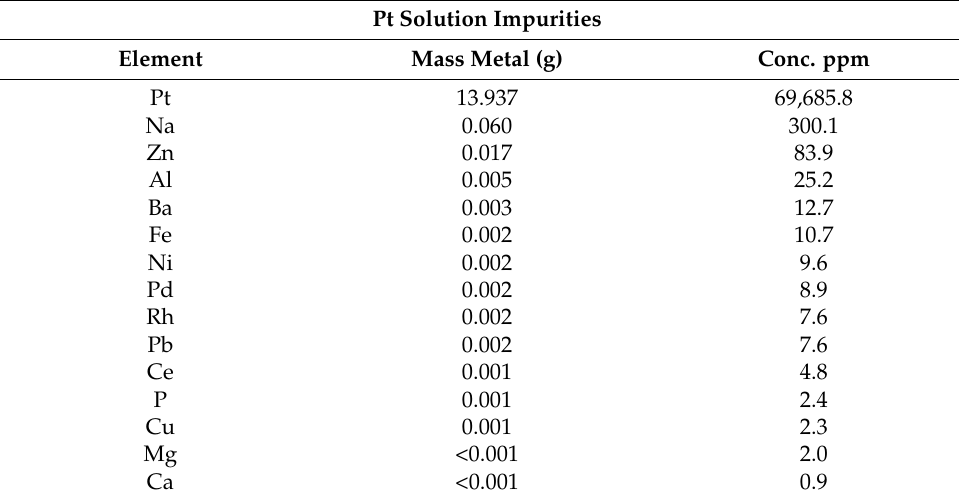
Table 5. ICP analysis of Pt sample and the impurities detected.